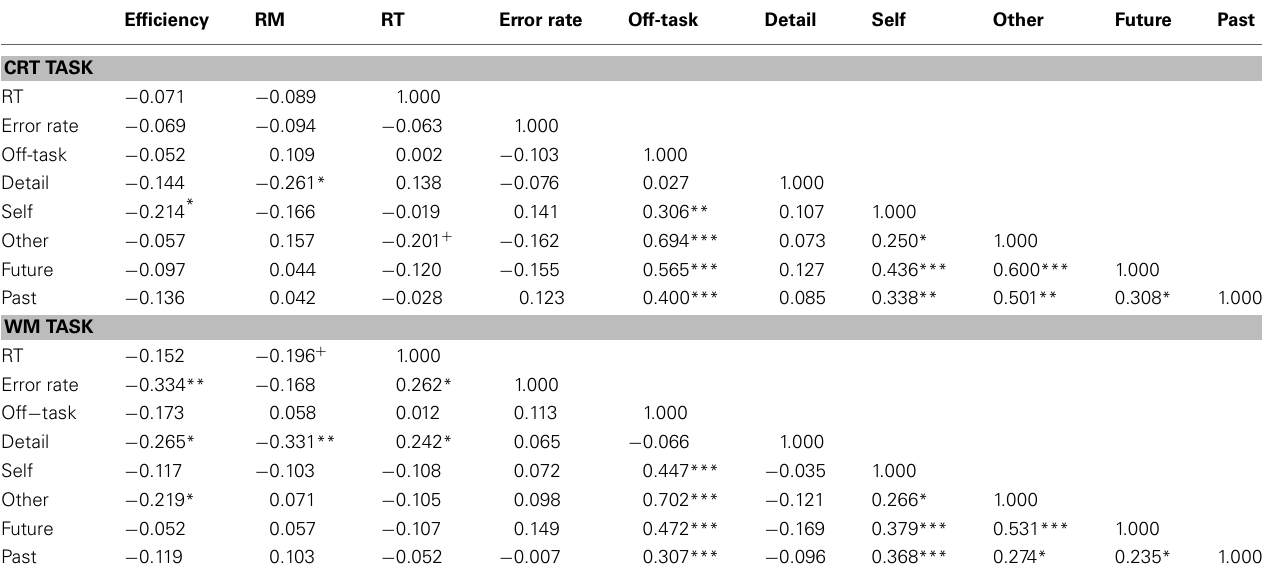
Table 2 | Correlation matrix for SGT ratings, task performance and MEPS